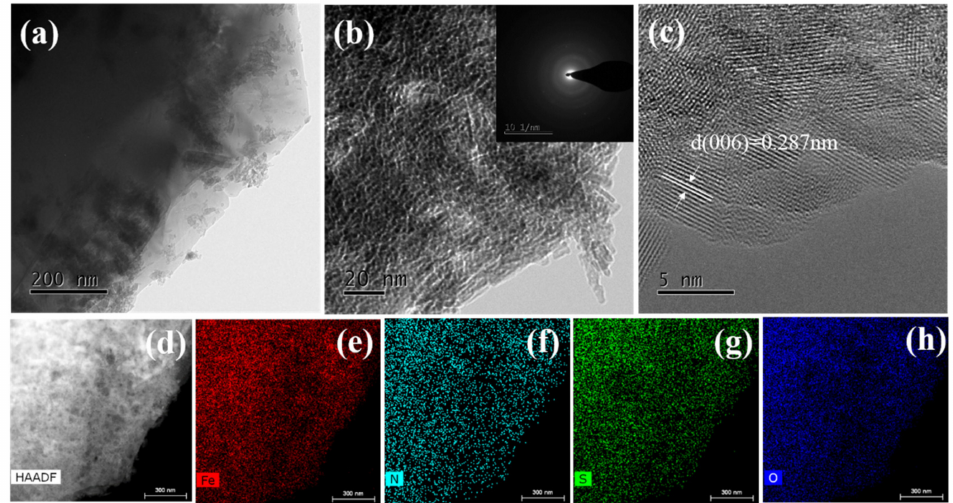
Figure 3. ( a , b ) TEM images (the inset shows SAED), ( c ) HRTEM image, and ( d – h ) HAADF-TEM diagrams of (NH 4 )Fe 3 (SO 4 ) 2 (OH) 6 and the corresponding EDS elemental mapping